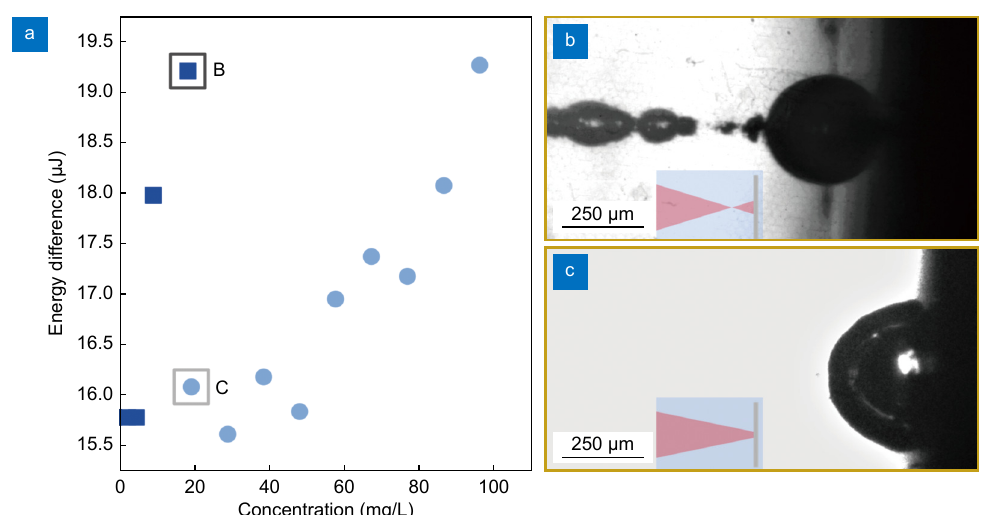
Fig. 4 | Energy difference of CBs produced in a pure colloid compared to the respective CB produced in water with different colloid concentra- tions and with the focal plane shifted into the liquid layer (dark blue squares) as well as the focal plane virtually shifted behind the target (light blue circles) ( a ). Images show exemplary CBs with the focal plane shifted into the liquid layer ( b ) and virtually shifted behind the target ( c ) at a NP concentration of approximately 20 mg/L as marked by the squares in (a).